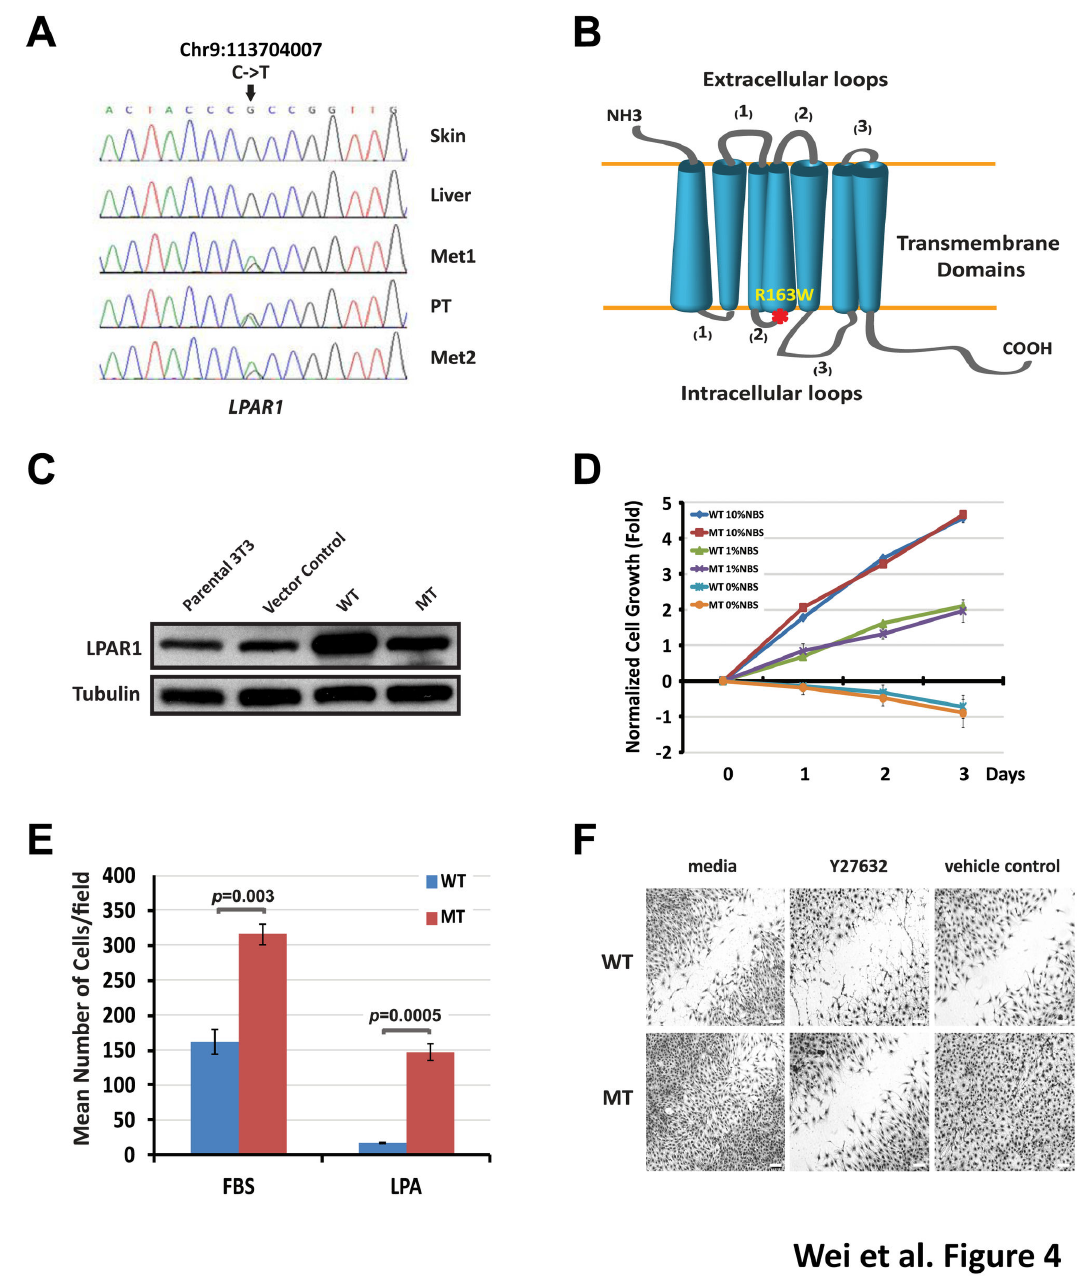
Figure 4. LPAR1 (R163W) mutation does not affect cell growth, but causes increased cell motility. ( A ) Sanger sequencing validated the LPAR1 mutation. The mutation was present only in tumors, not in the germ line DNAs. ( B ) A schematic diagram shows the position of the R163W mutation (*) which was located at the junction of the second intracellular domain and fourth transmembrane domain of LPAR1. ( C ) A Western blot showed forced expression of human wild-type (WT), R163W mutant (MT), and mouse endogenous LPAR1 receptors in NIH3T3 cells using a rabbit polyclonal antibody from Novus Biologicals (Littleton, CO). ( D ) NIH3T3 cells expressing mutation (MT) and wild-type of LPAR1 (WT) grew at a similar rate in 0, 1, and 10% new born bovine serum (NBS). Each time point was normalized to day 0, and the average cell growth was plotted. Error bars represent standard deviations. ( E ) NIH3T3 cells expressing MT LPAR1 showed a significant increased motility compared to those expressing WT LPAR1 in response to serum or LPA gradient in a Boyden chamber assay. Error bars represent standard errors. ( F ) Scratch assays confirmed the increased motility of NIH3T3 cells expressing MT compared to WT LPAR1. A Rho kinase (ROCK)-specific inhibitor, Y27632, reduced the cell motility mediated by the MT LPAR1 receptor. White scale bars are 200 μm. doi: 10.1371/journal.pone.0077731.g004 PLOS ONE |